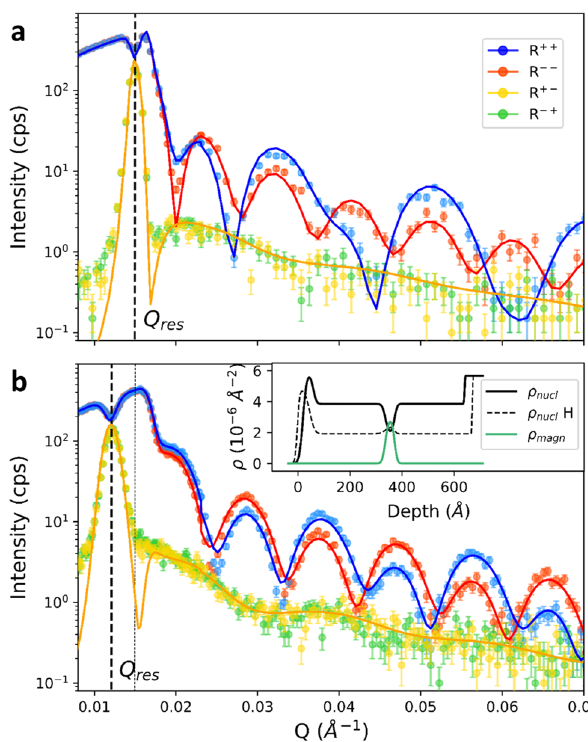
Fig. 2 Polarized neutron re fl ectivity before and after hydrogen absorption. a as-prepared sample and b fully hydrogenated sample. The data were taken at the NREX re fl ectometer at room temperature in a magnetic fi eld of 5 Oe perpendicular to the scattering plane. The dashed lines mark the position of the waveguide resonance in the spin- fl ip channels, Q res . The solid lines are the results of fi ts described in the text. The inset shows the corresponding nuclear and magnetic scattering length pro fi les. Error bars indicate the statistical